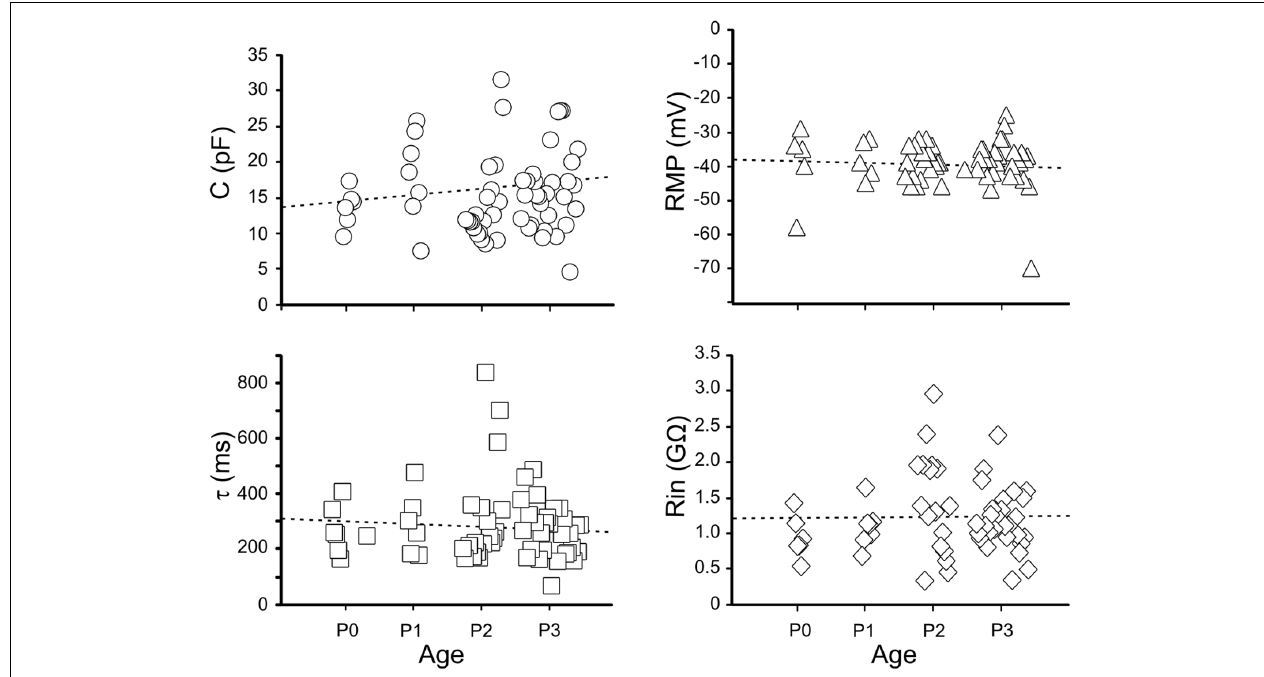
FIGURE 3 | Passive membrane properties of immature granule cells. Individual values of capacitance (C, open circles), resting membrane potential (RMP, open triangles), decay time constant ( τ , open squares) and membrane input resistance (R in , open diamonds), detected between P0 and P3.